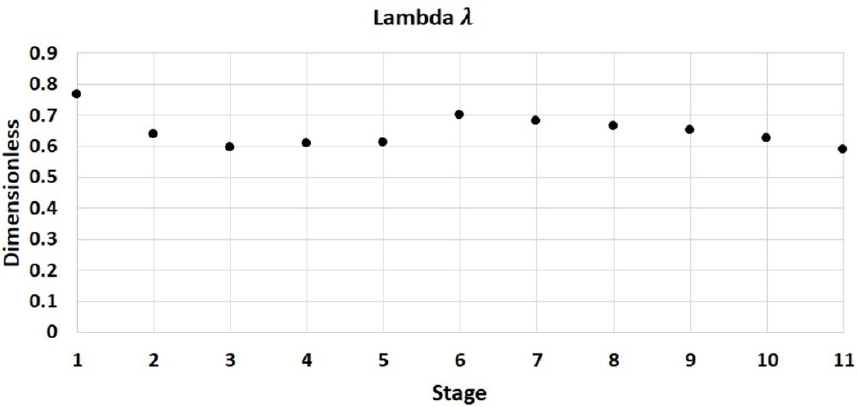
Figure 2. Estimation of parameter λ from HFDT at design point and 100% ω max .